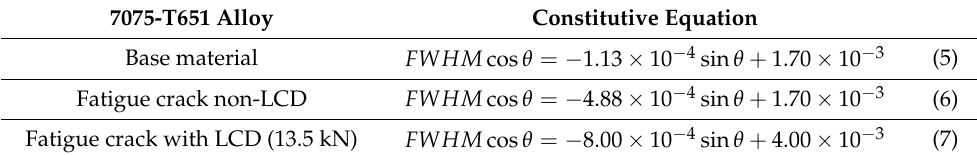
Table 4. Constitutive equations obtained from the fitting to the Williamson–Hall equation. 7075-T651